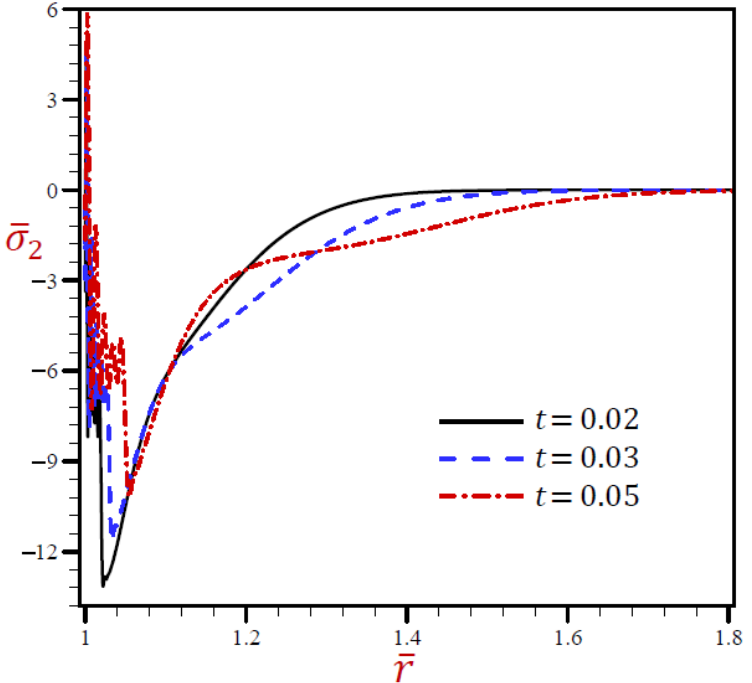
Figure 11. The influence of t on circumferential stress σ 2 through radial direction of spherical hole using RDPL model.